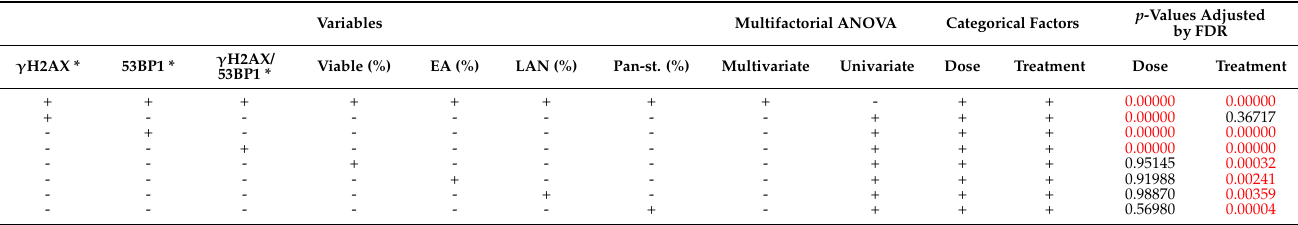
* mean, foci per cell; + the data were included in analysis; - data were not included in analysis. Statistically significant values are marked red.